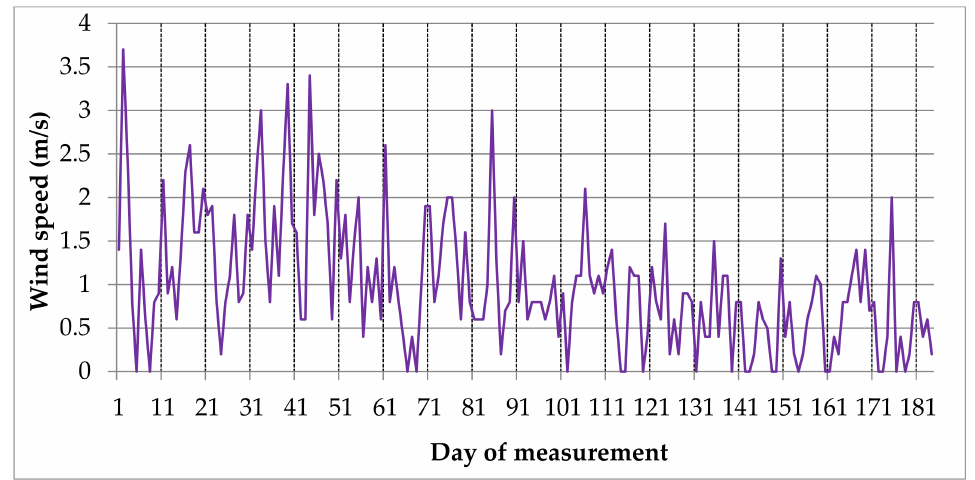
Figure 8. Daily variations of wind speed during the measurement